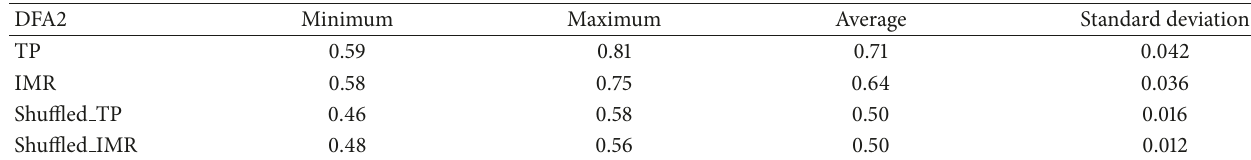
Table 1: The main parameters of scaling exponents of the OLR sequence on TP and